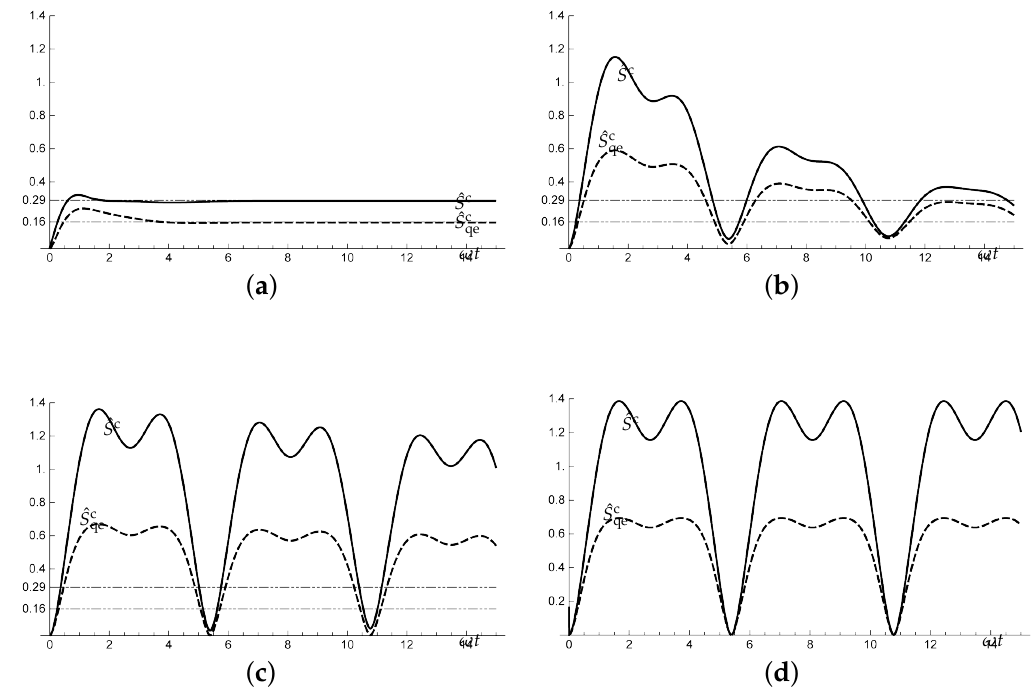
Figure 4. Time dependence of ˆ S c ( ----- ) and ˆ S c qe ( --- ) in dissipative and non-dissipative systems with K − 1 = ( β J ) − 1 = 0.7 and h = β g µ B H = 3/7 for the competing cases. Parts ( a – c ) show cases with scaled dissipation rates of e / ω = 1, 0.1, and 0.01, respectively. The dot-dot-dashed lines ( - - ) in parts ( a – c ) represent the asymptotes of the ˆ S c and ˆ S c qe curves, respectively. In part ( d ), which is the non-dissipation case ( e = 0), all the curves have the same phase and show a kind of “twin-peaks” oscillation.